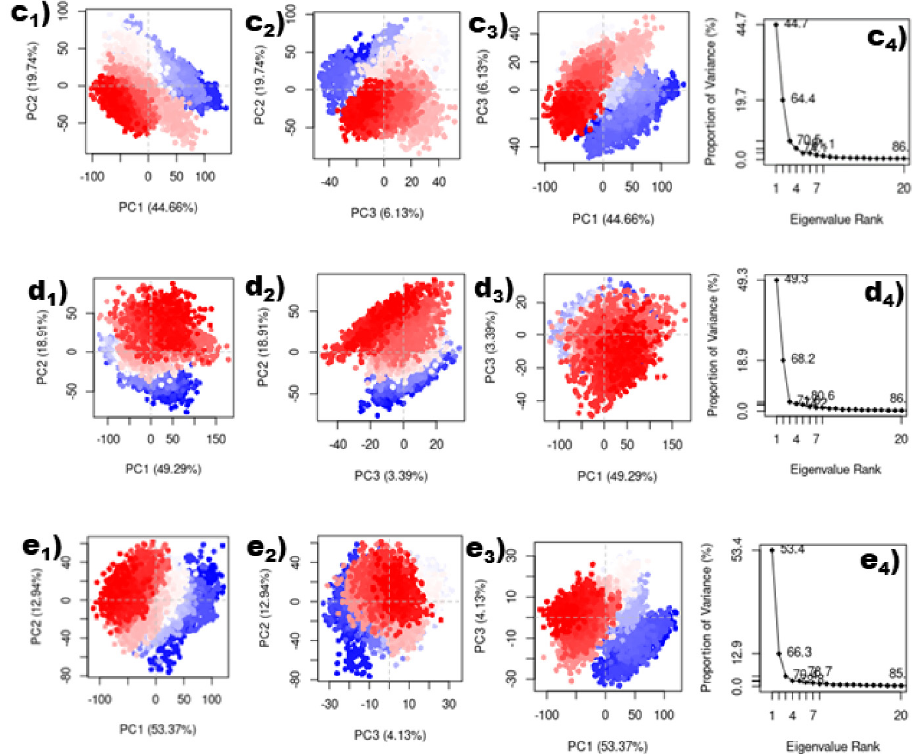
Figure 8. Principal component analysis of top five compounds. ( a ) Gallicynoic Acid F, ( b ) H2 ‐ Erythro ‐ Neopterin, ( c ) Nigcollin C, ( d ) NPA024545, and ( e ) Vaccinol.